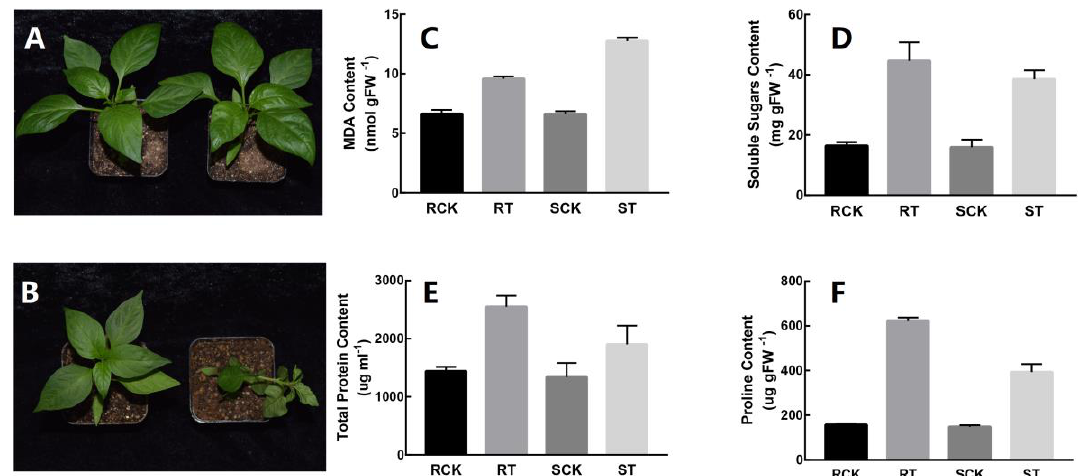
Figure 1. Phenotypic and physiological responses of 17CL30 (heat-tolerant cultivar) and 05S180 (heat-